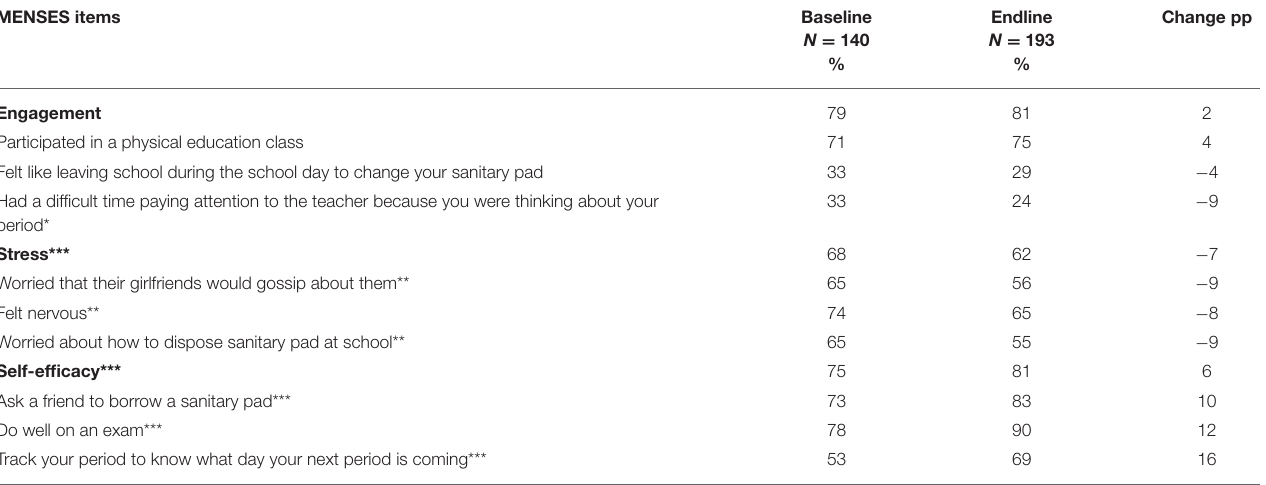
TABLE 4 | MENSES scores and most improved items over time a . MENSES